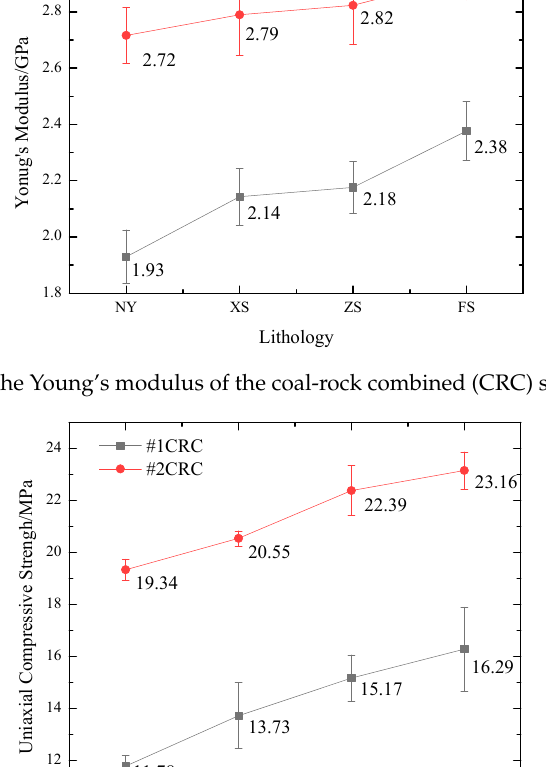
Figure 4. The Young’s modulus of the coal-rock combined (CRC) specimens.